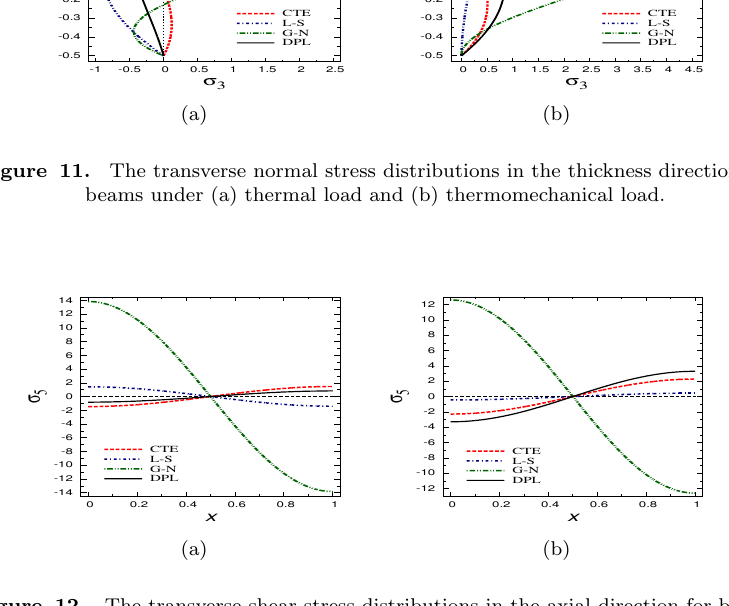
Figure 12. The transverse shear stress distributions in the axial direction for beams under (a) thermal load and (b) thermomechanical load.